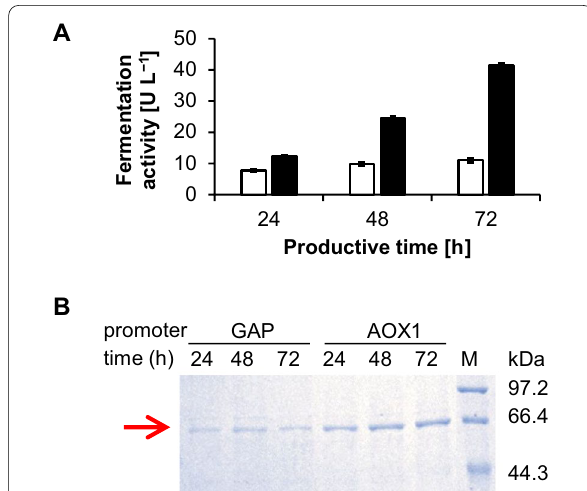
Fig. 1 Initial assessment for the best CHMO Acineto ‑Mut extracellular production in shake flask fermentations. A Fermentation activity of CHMO Acineto ‑Mut under AOX 1 promoter ( ■ ) and GAP promoter ( □ ) with different fermentation time. B SDS‑PAGE analysis of the extracellular expression of CHMO Acineto ‑Mut by P. pastoris X33 under the control of GAP and AOX 1 promoters, respectively. The red arrow indicated CHMO